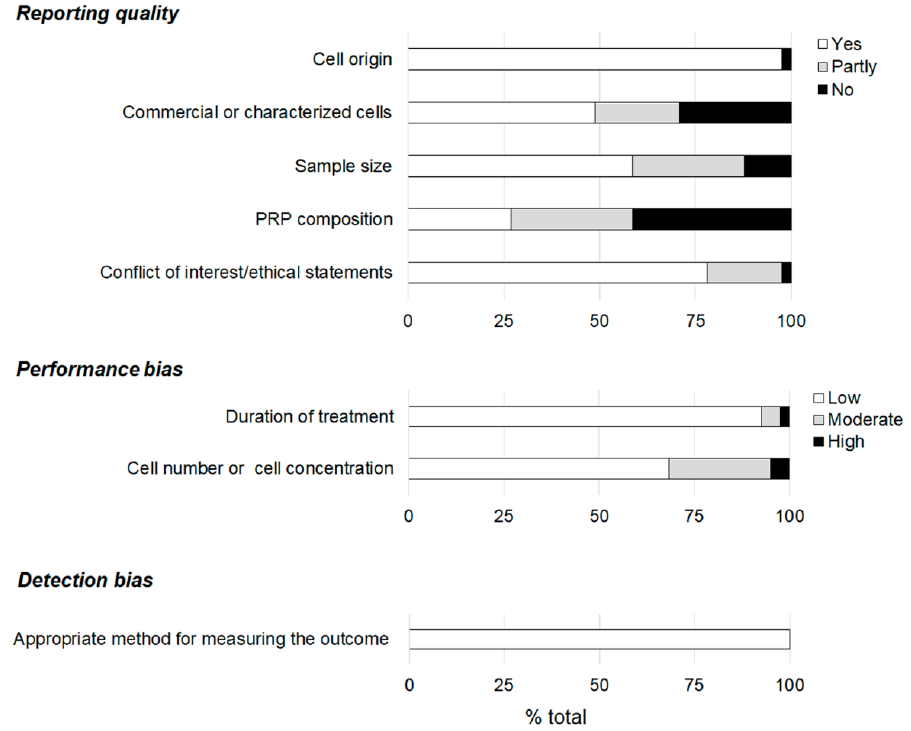
Figure 2. Assessment of the quality and risk of bias of the included studies according to the criteria reported by Golbach et al. [51].